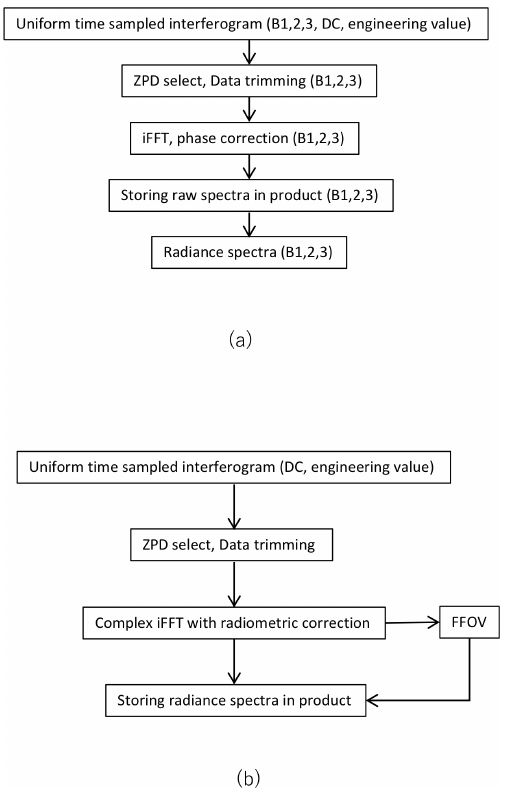
Figure 7. Processing flow for SWIR bands (a) and for TIR bands (b) .